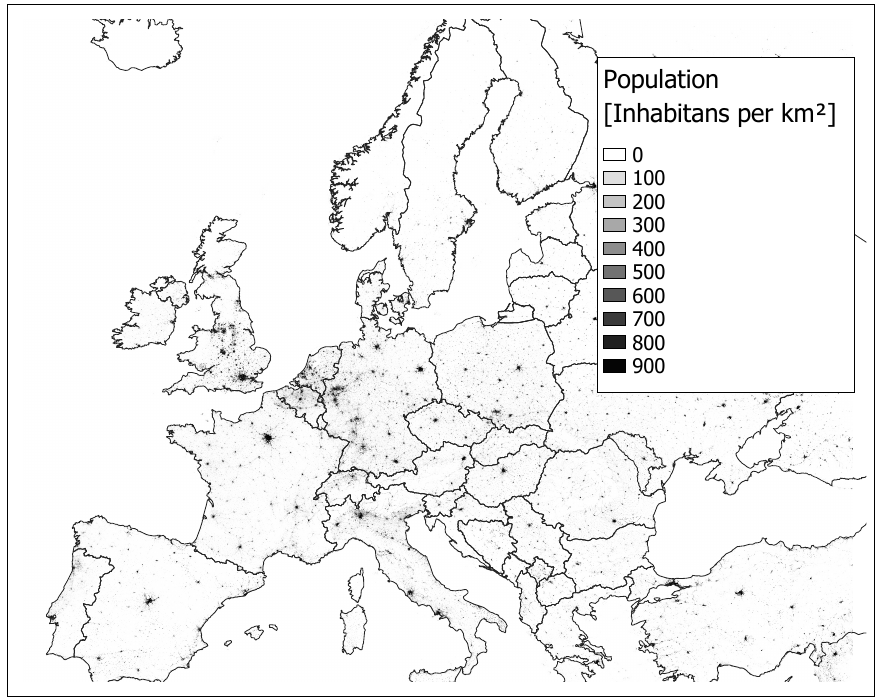
Figure 6. Geographical coverage of population density in Europe. Own illustration based on